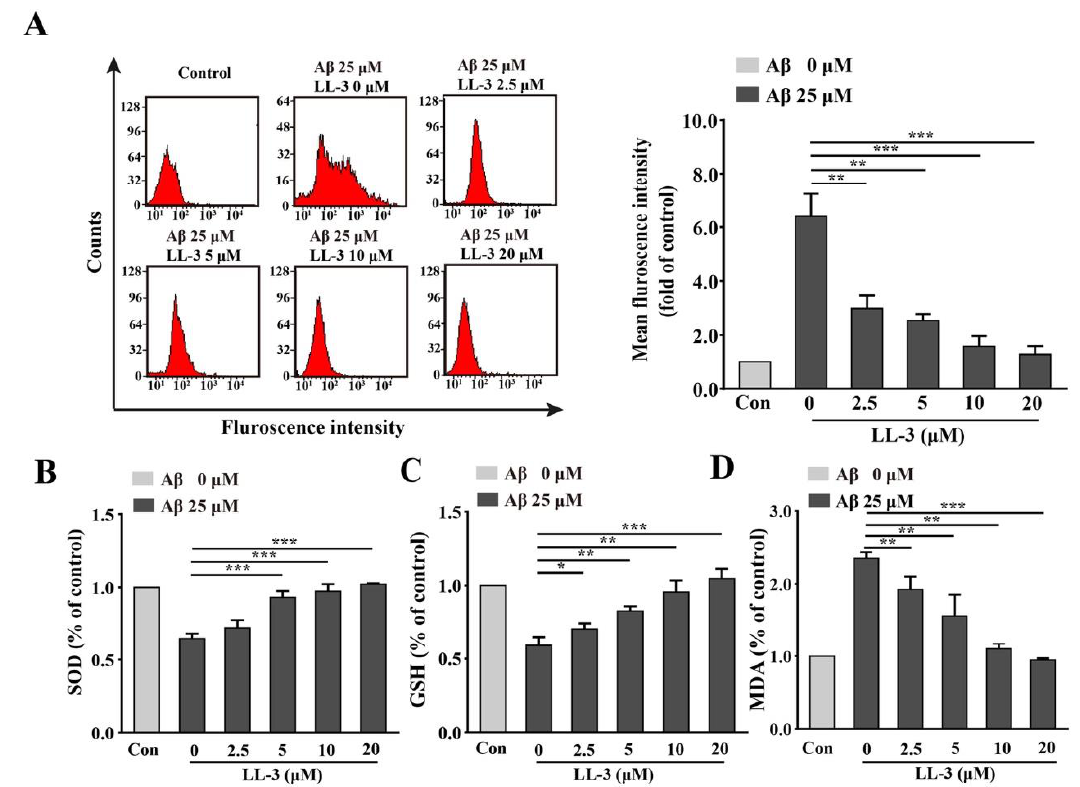
Figure 3. Effects of LL- 3 on Aβ 25-35 -induced oxidative stress. SH-SY5Y cells were pretreated with different concentrations of LL-3 for 30 min in six-well plates and co- incubated with 25 μM Aβ 25-35 for another 24 h. The levels of reactive oxygen species (ROS) ( A ), superoxide dismutase (SOD) ( B ), glutathione (GSH) ( C ), and malondialdehyde (MDA) ( D ) were detected through flow cytometric assay using 2’,7’ -dichlorodihydrofluorescein diacetate (DCFH-DA) probe and SOD, GSH, and MDA assays according to manufacturer protocols. All these experiments were detected three times and shown with mean ± SD, * p < 0.05, ** p < 0.01, *** p < 0.001 compared to Aβ 25-35 alone.